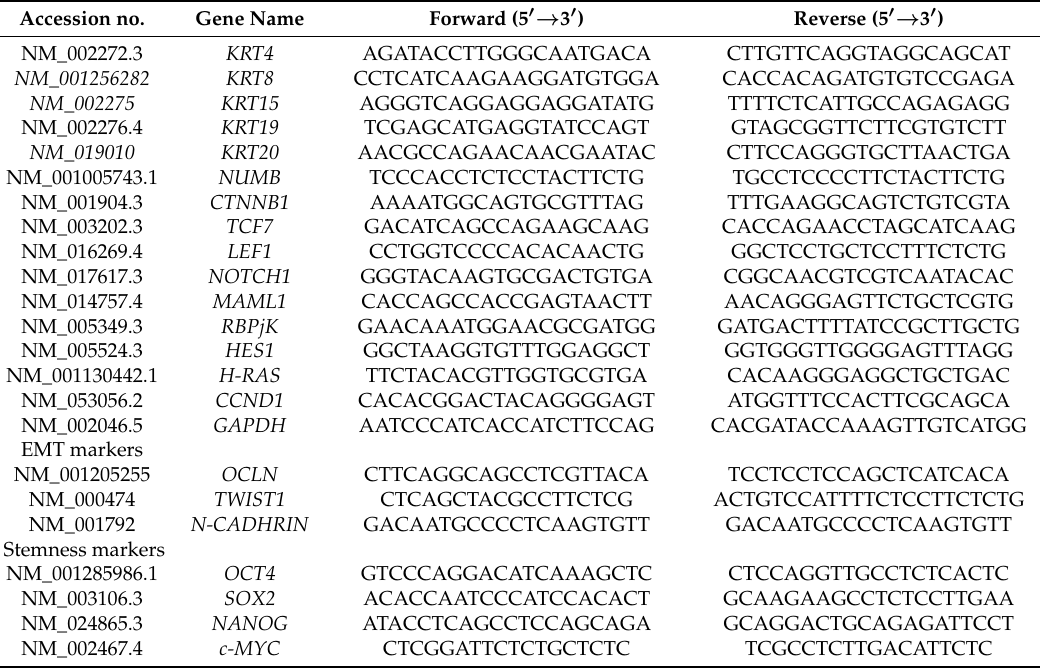
Table 1. List of primers used for quantification of specific gene expression.